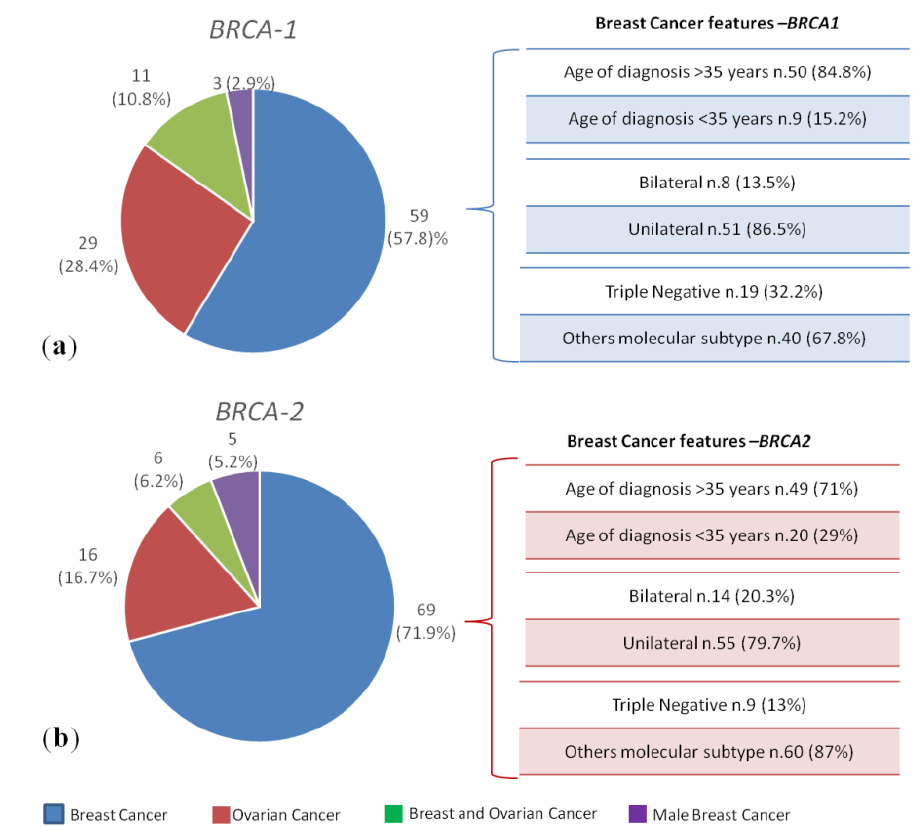
Figure 1. Breast and / or ovarian cancer patients harboring germline BRCA1 / 2 pathogenic variants (PVs). 200 (14.8%) out of 1346 probands with breast and / or ovarian cancer had germline PVs in BRCA1 / 2 genes. ( a ) 102 (51%) were BRCA1 PV carriers, ( b ) 96 (48%) were BRCA2 PV carriers and 2 patients (1%) showed a double heterozygosity for BRCA1 and BRCA2 PVs.